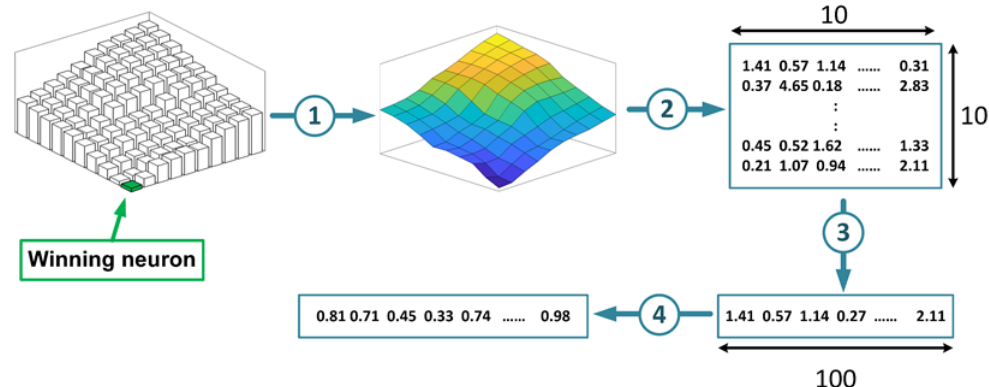
Figure 5. Transformation of the SOM outputs into input vectors for the subordinate network in the cascaded neural network (CdNN) structure.